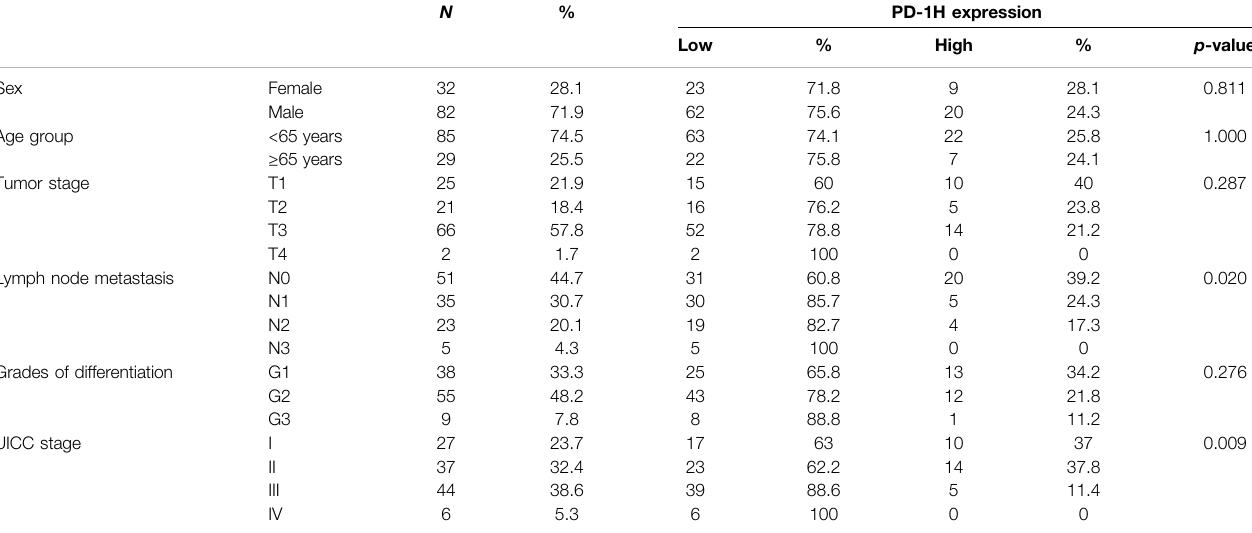
TABLE 1 | The correlation of PD-1H expression and clinicopathologic parameters in 114 patients with ESCC. N % PD-1H expression